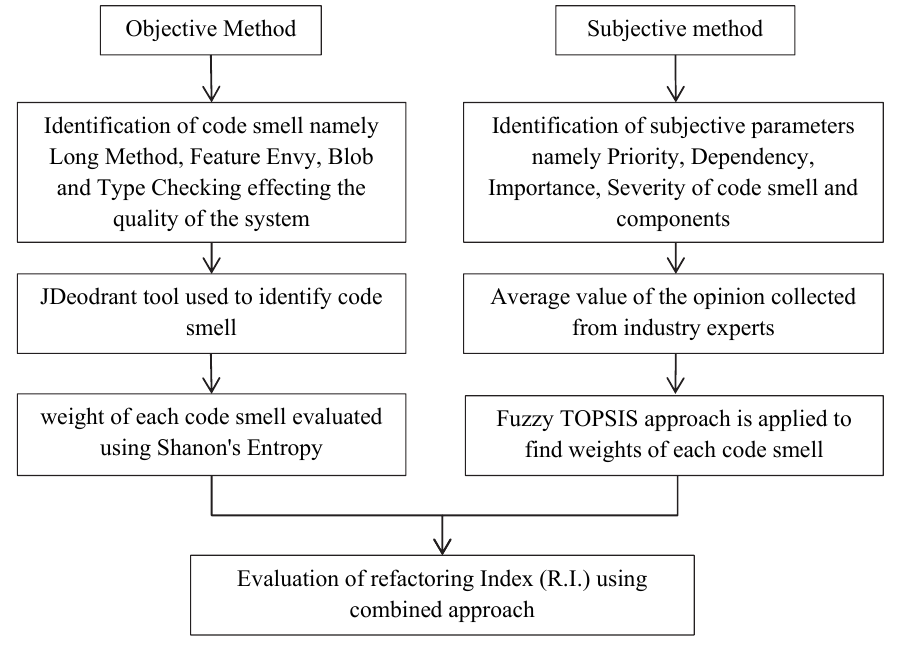
Fig. 1. Framework for Refactoring